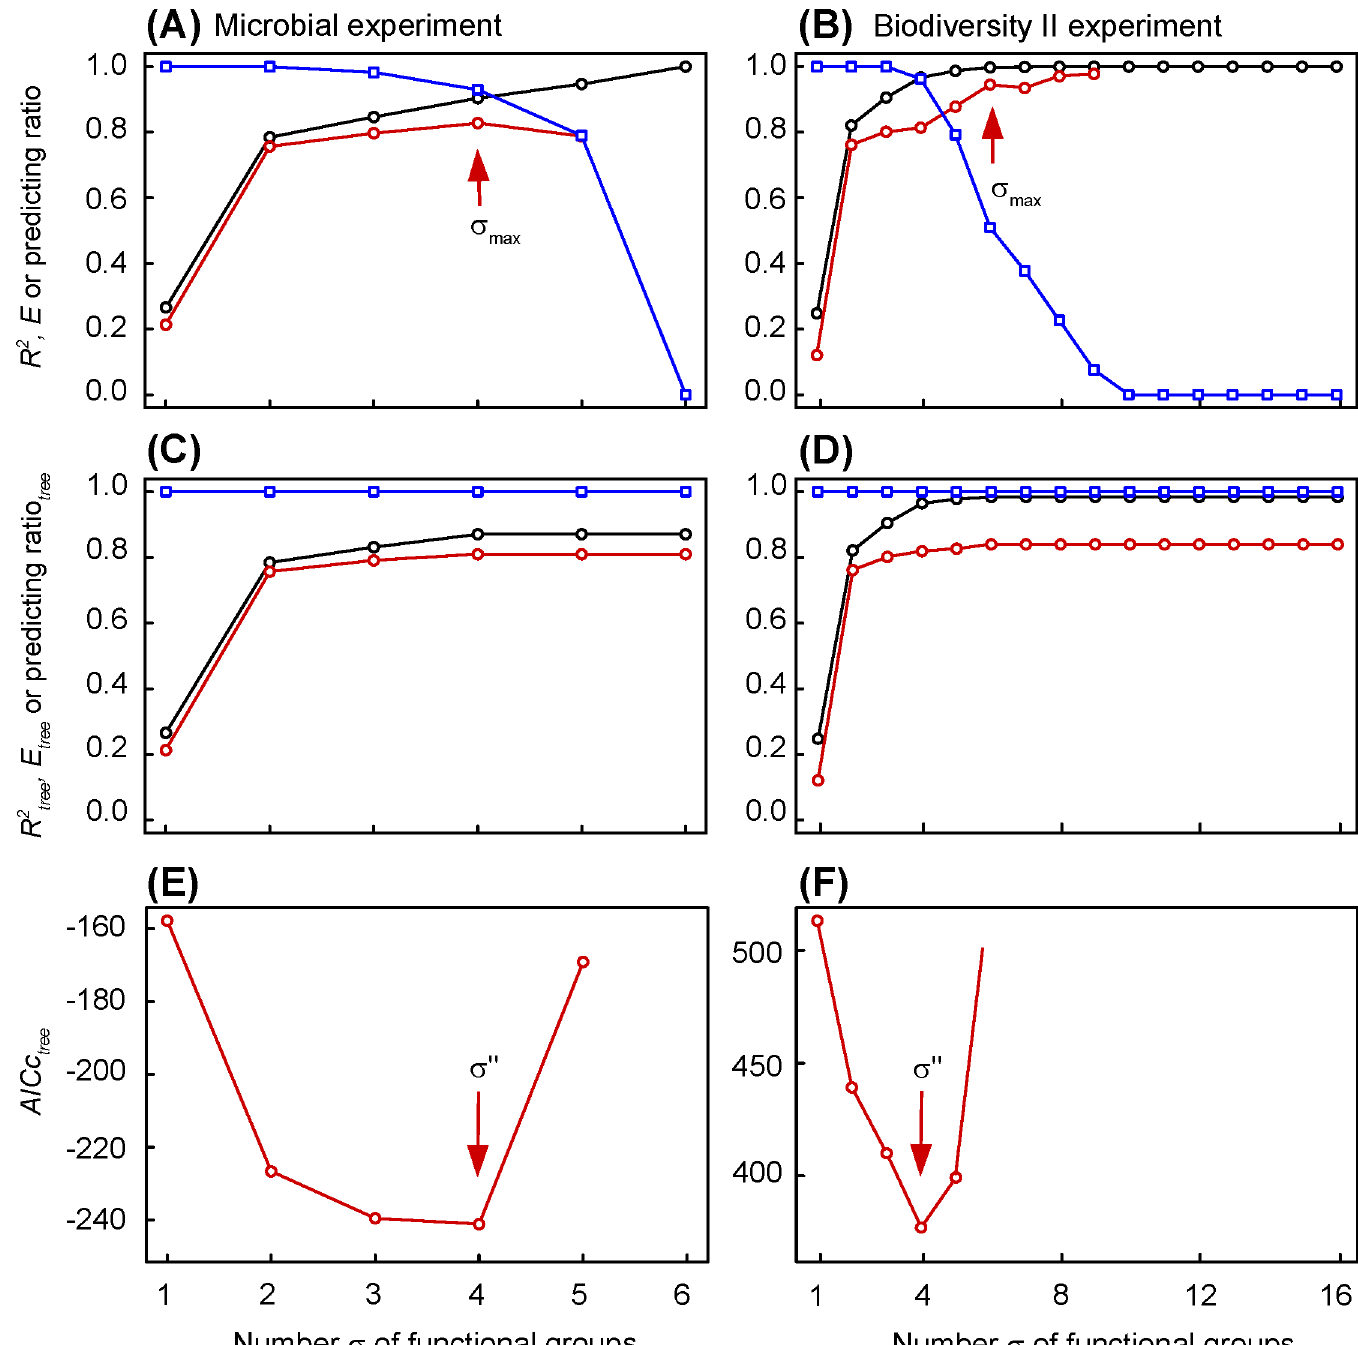
Fig 2. Changes in coefficient of determination, coefficient of efficiency, predicting ratio and Akaïke index versus the number of functional groups. (A), (C) and (E) Microbial experiment of Langenheder et al. [16]. (B), (D) and (F) Biodiversity II experiment of Tilman et al. [17]. (A) and (B) Coefficient of determination (black circle), coefficient of efficiency (red circle) and predicting ratio (blue square) of each clustering model. The arrow indicates the first local maximum of the coefficient of efficiency, located at σ max functional groups. (C) and (D) Coefficient of determination (black circle), coefficient of efficiency (red circle) and predicting ratio (blue square) of whole tree of species clustering. (E) and (F) tree Aka ï ke index corrected for the second order bias ( AICc ).The arrow indicates the minimum value of Aka ï ke index, that corresponds to the optimum number σ" of functional